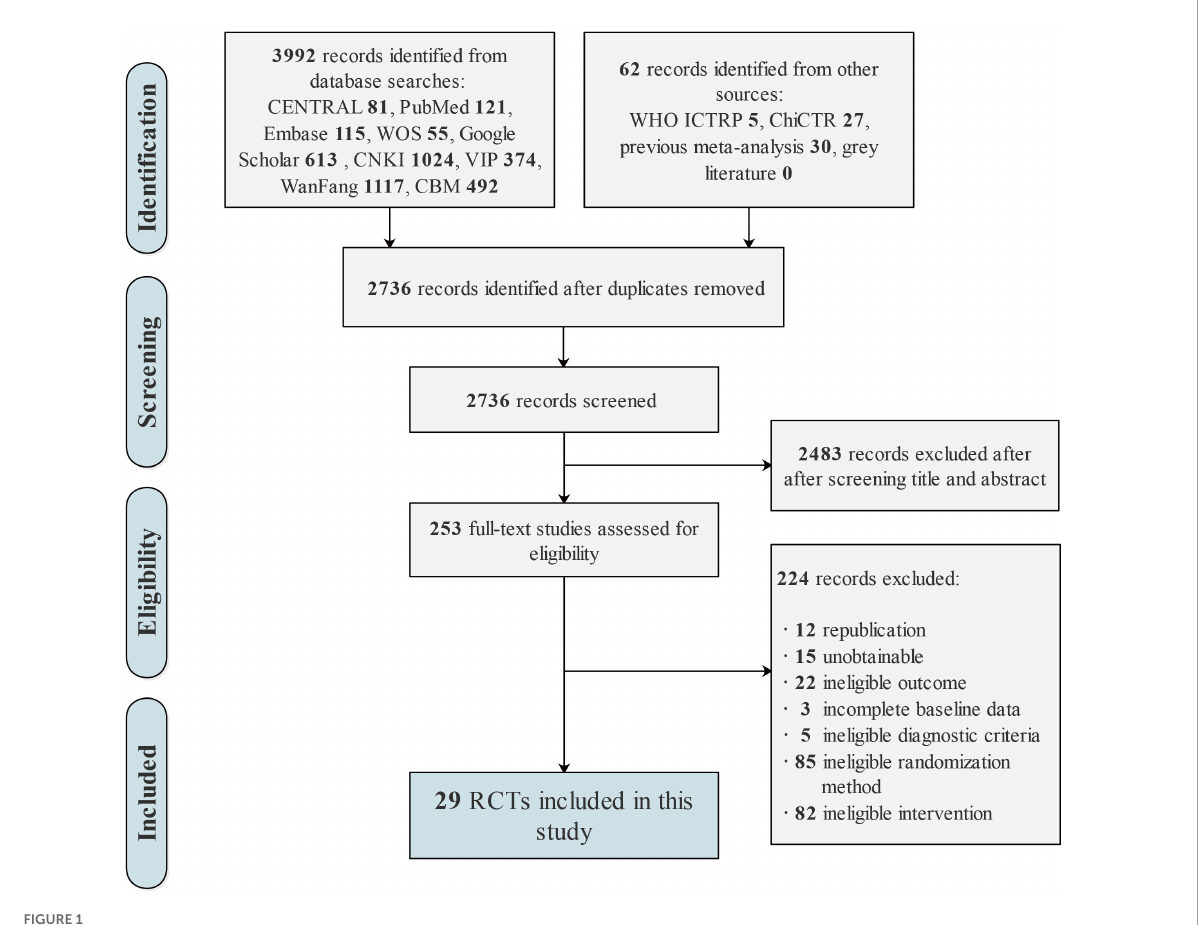
FIGURE1 Flow chart of study selection.